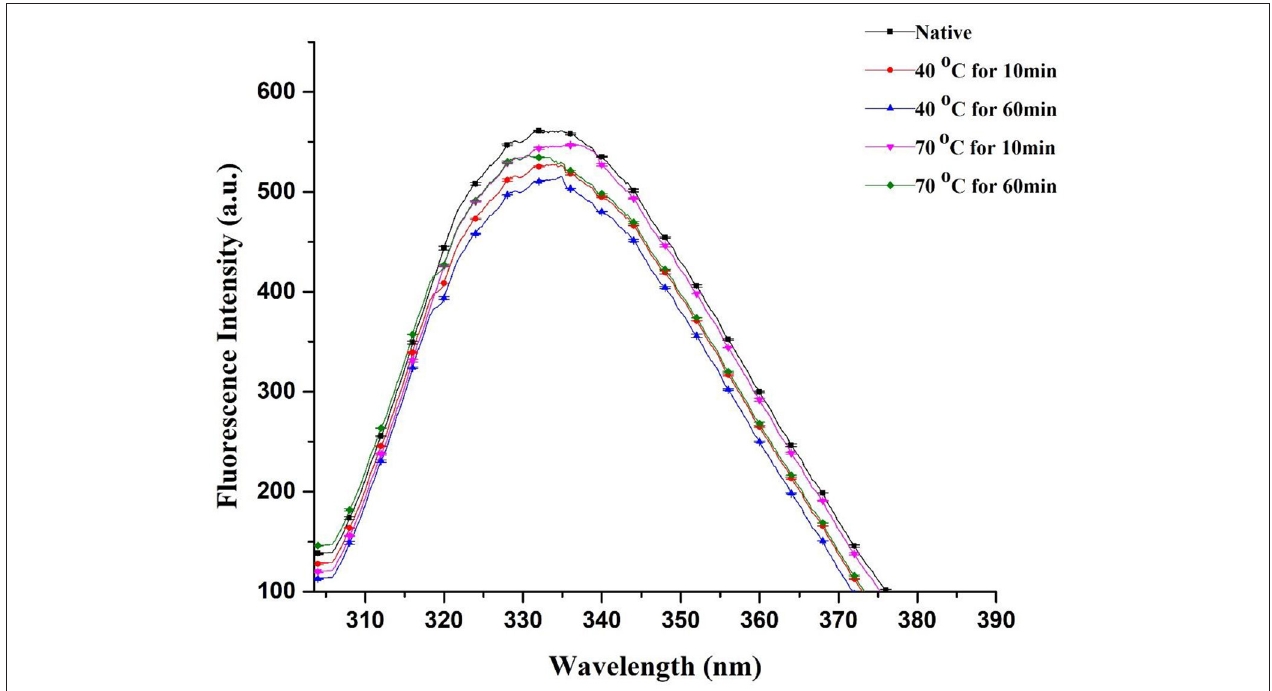
FIGURE 4 | Fluorescence spectra of native and thermally treated PPO at different holding times and various temperatures and correlation analysis between redshift and inactivation rate. All data were the means ± SD